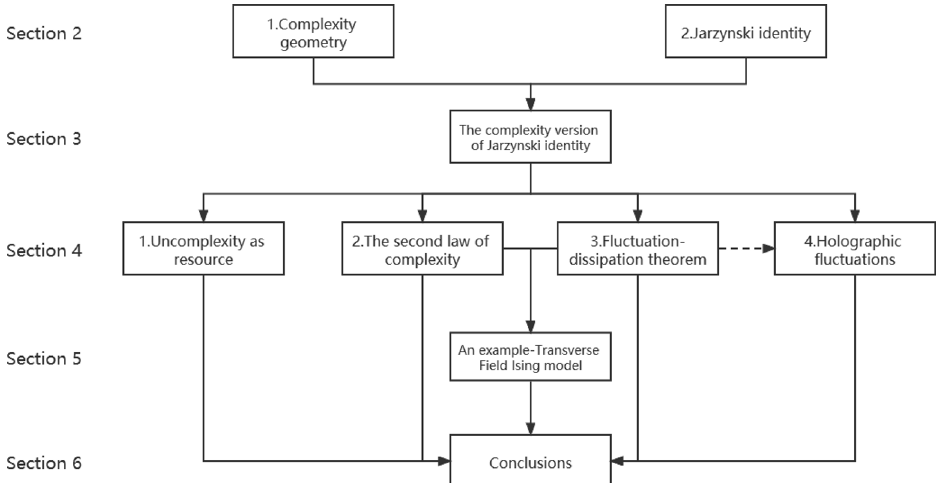
Figure 1 . Flowchart of the paper. The reason for connecting “Fluctuation-dissipation theorem” and “Holographic fluctuations” with a dashed line is that the former might be a potential tool to help us quantitatively study the